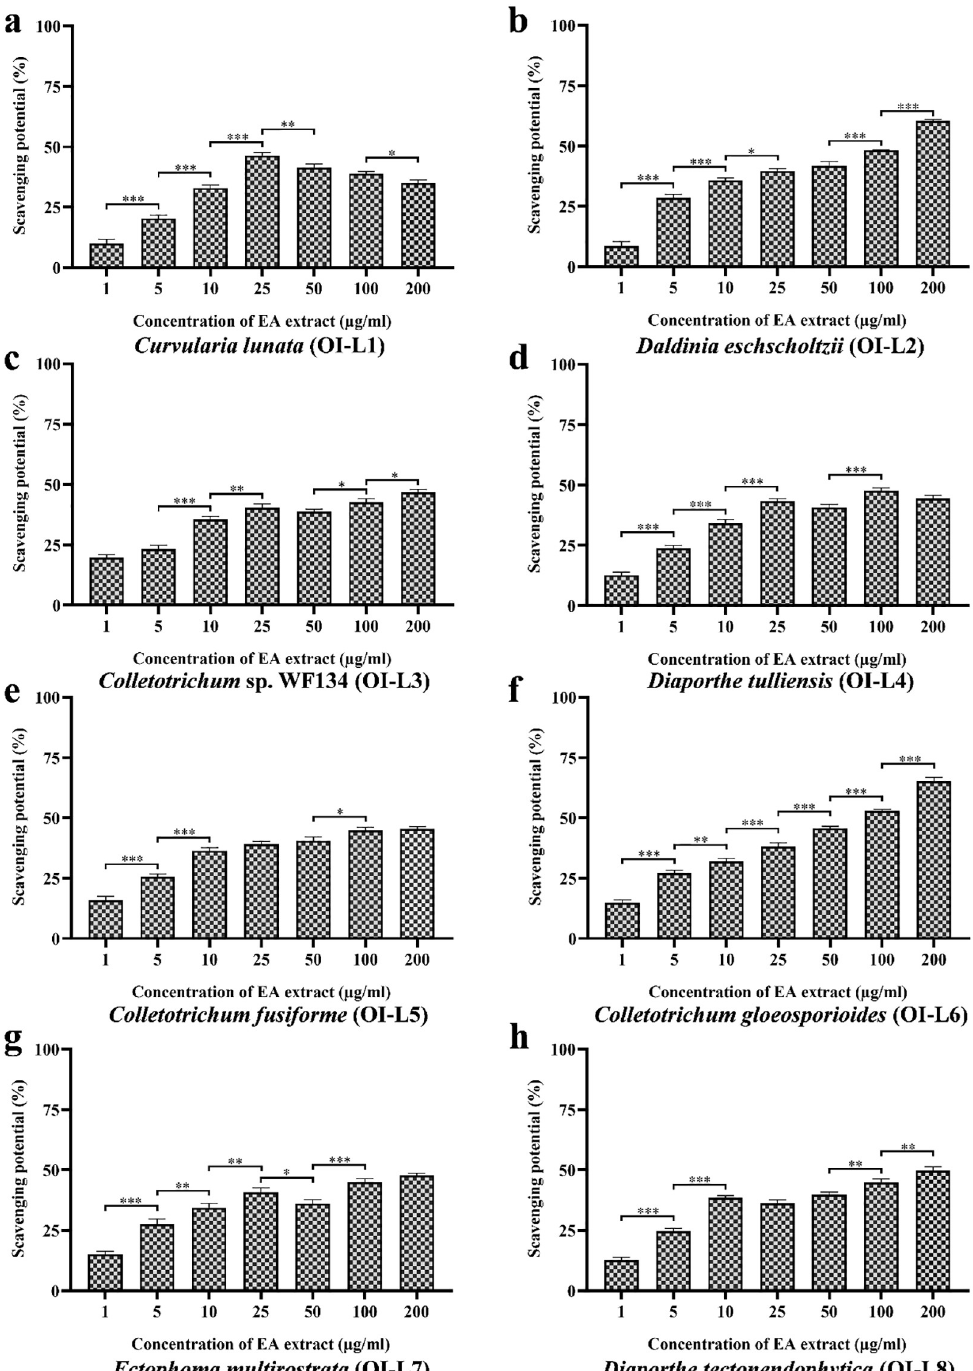
Fig 6. Nitric oxide scavenging potential of EA extract of fungal endophytes (a) C . lunata , (b) D . eschscholtzii , (c) Colletotrichum sp. WF134, (d) D . tulliensis , (e) C . fusiforme , (f) C . gloeosporioides , (g) E . multirostrata and (h) D . tectonendophytica . All the experiments were performed in triplicate. P-value was calculated by comparing means ± SD of the nitric oxide radical scavenging potential (%), using one-way ANOVA followed by Tukey to determine statistical significance. Statistical significance are as follows; ��� , P � 0.001; �� , P � 0.002; � , P � 0.033.